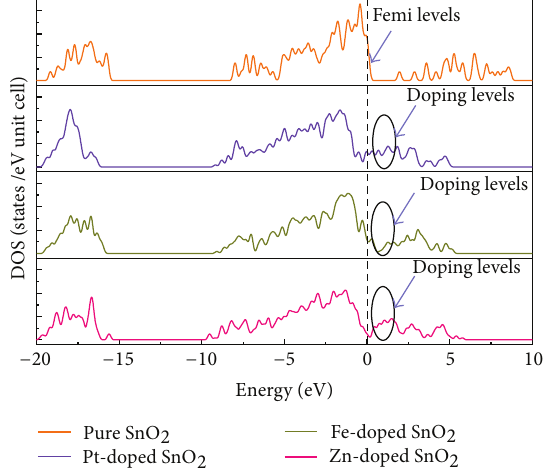
Figure 11: PDOS of CO molecule after